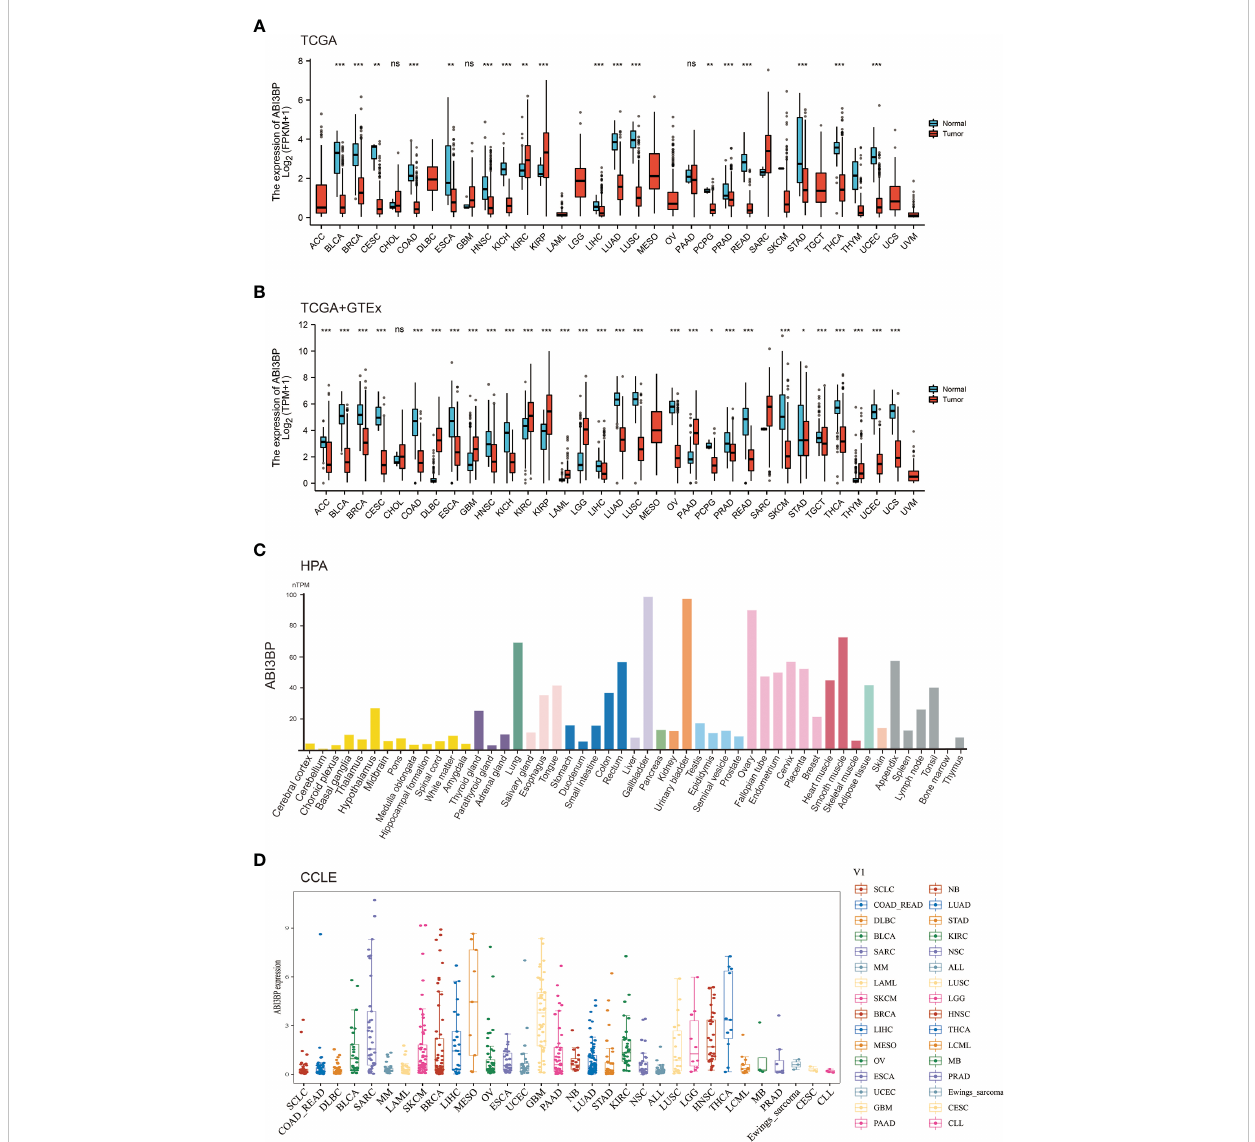
FIGURE 1 ABI3BP expression pro fi le. (A) ABI3BP expression levels in cancer and adjacent normal tissues from TCGA database. (B) Differences in ABI3BP expression levels between tumor and normal tissues in TCGA and GTEx databases. (C) ABI3BP protein expression level in HPA database. (D) ABI3BP expression level of tumor cell lines in CCLE database. *p < 0.05, **p < 0.01, ***p <